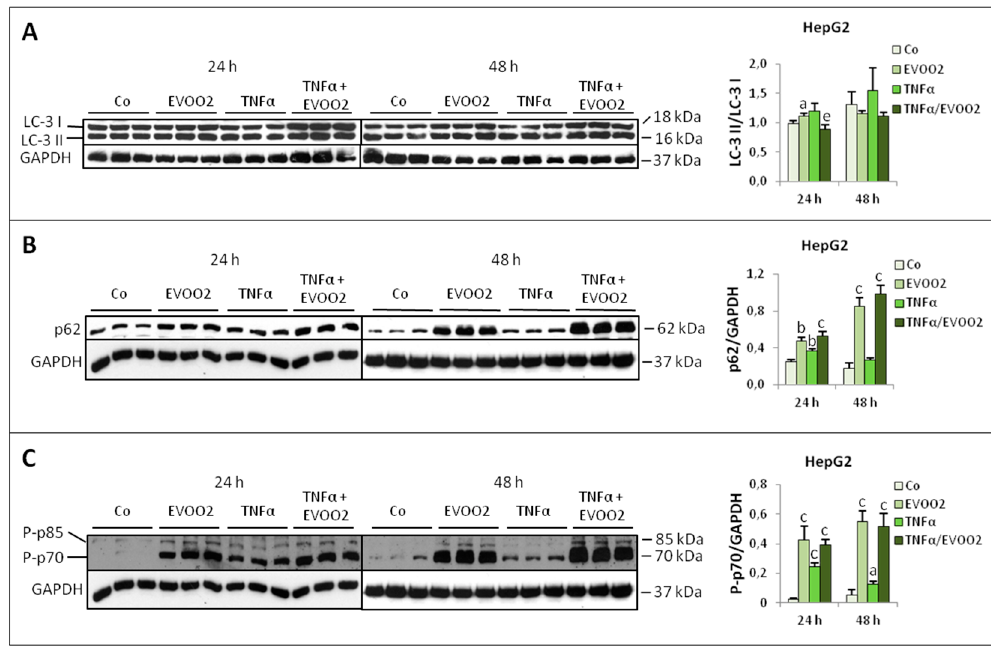
Figure 11. The combined treatment of EVOO extract and TNF α modulates protein turnover in HepG2 cells. ( A – C ) Expression of LC-3 ( A ), p62 ( B ) and P-p70 ( C ) in HepG2 cell lines incubated for 24 and 48 h with EVOO2 extract in the presence or absence of TNF α . The results are representative of three experiments. The protein molecular weights are reported. Data are presented as mean ± SD. (a: p < 0.05, b: p < 0.01, c: p < 0.001 versus Control; e: p < 0.01 versus EVOO).